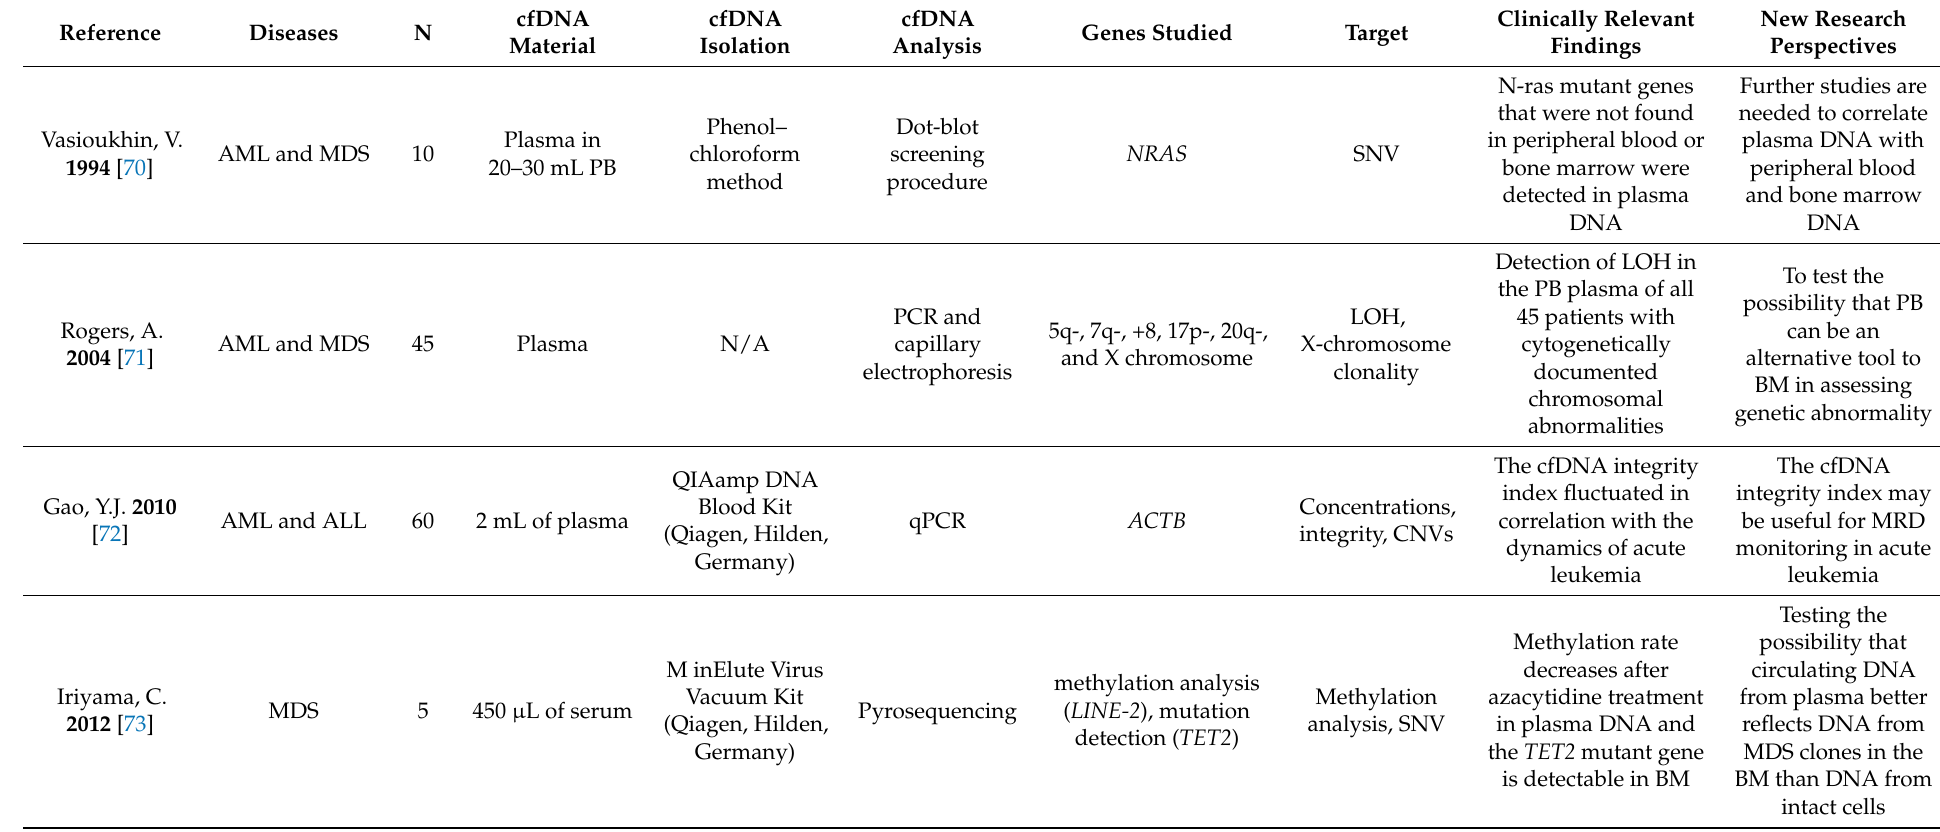
Table 2. Description of the studies examining cell-free DNA (cfDNA) for acute myeloid leukemia (AML)/myelodysplastic syndrome (MDS).